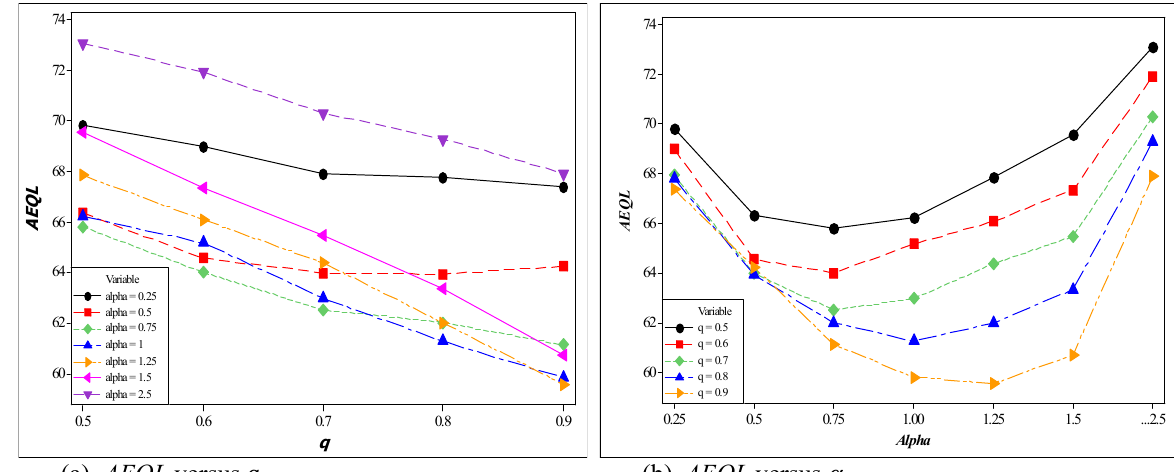
Fig. 3. Overall performance measure of the W-GWMA ( 𝑞, 𝛼 ) scheme when ( 𝑚, 𝑛 ) = (100,